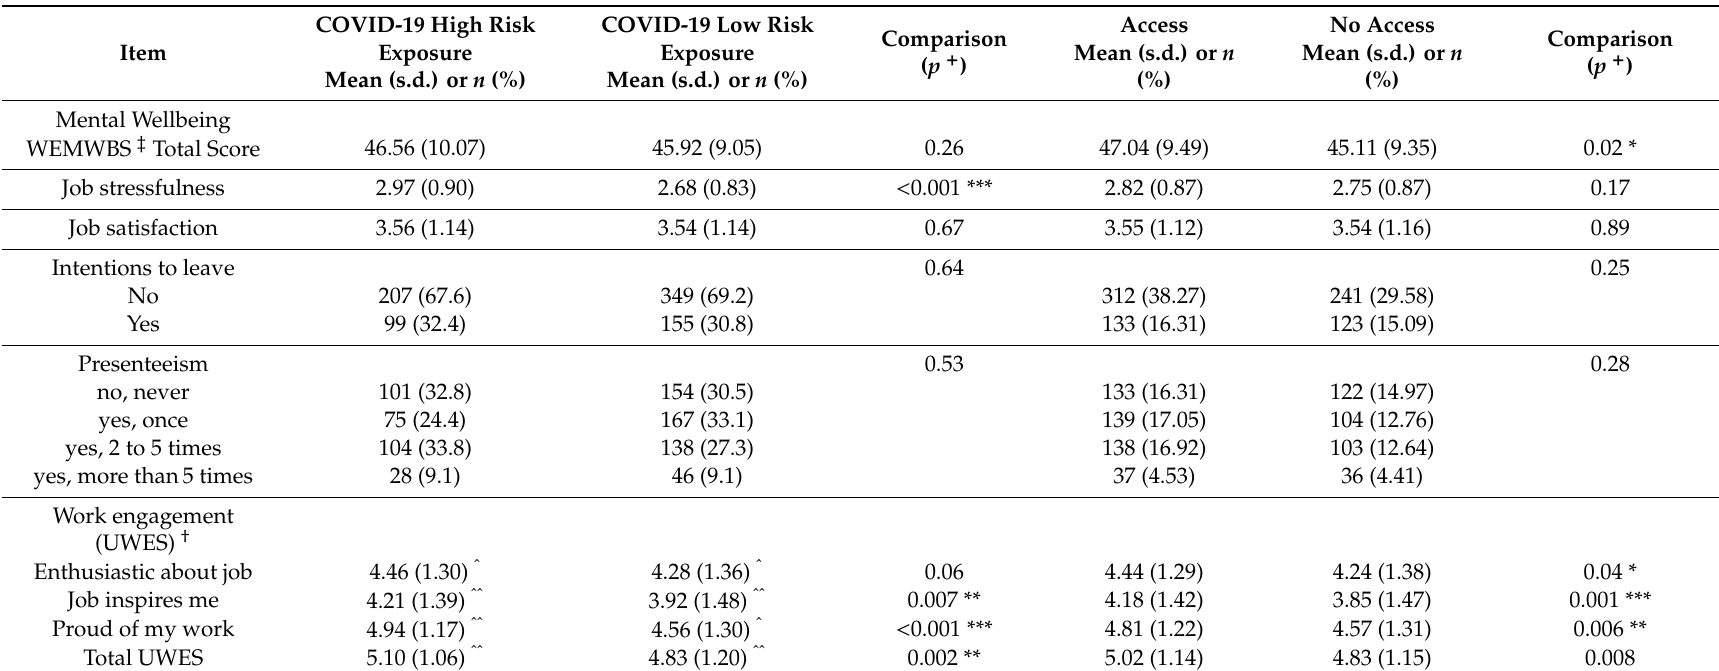
Table 3. Wellbeing and job perceptions by COVID-19 exposure and Centre Access ( n =